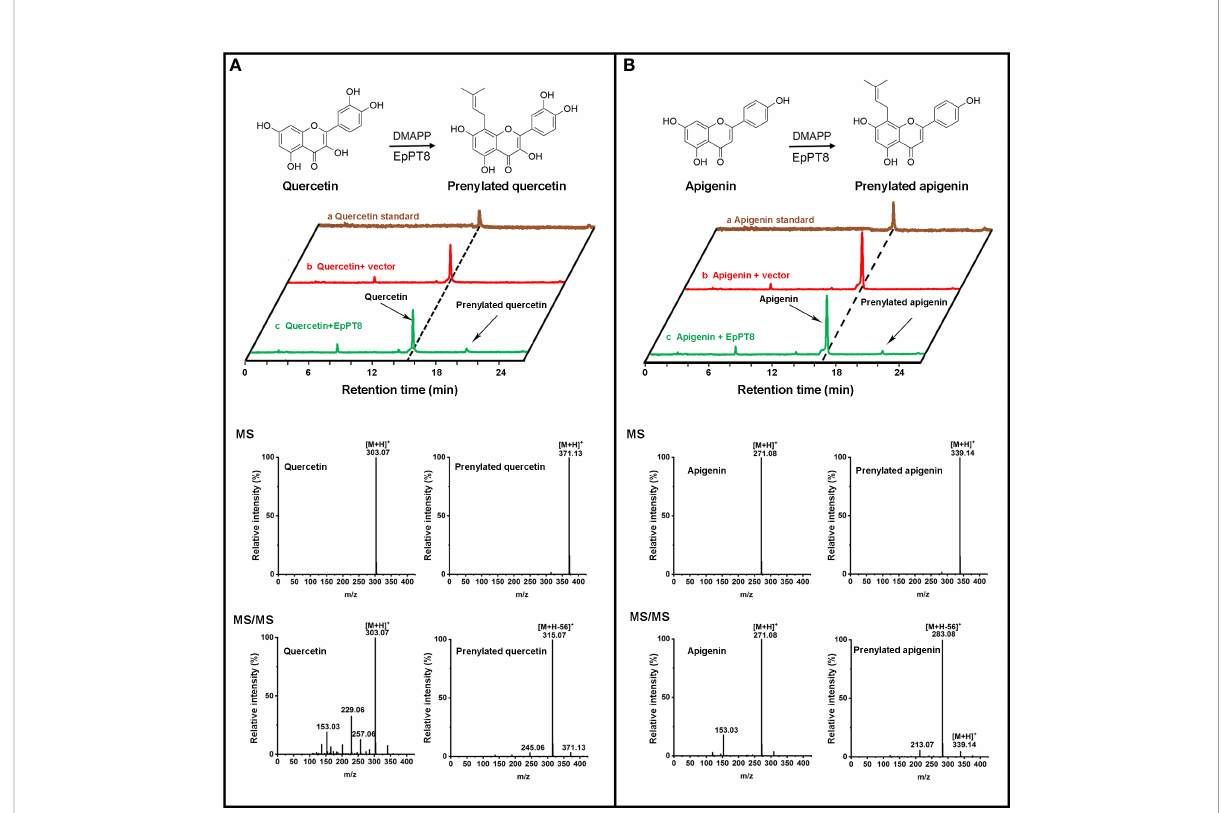
FIGURE 5 Determination of the enzymatic products of the recombinant EpPT8 protein with quercetin and apigenin as substrates. (A) The reaction with quercetin catalyzed by the recombinant EpPT8 protein. The HPLC chromatograph of reaction mix was shown in the upper panel; in the lower panel, MS (upper) and MS/MS (lower) chromatograms at 270 nm of quercetin and prenylated quercetin was on the left and right, respectively. (B) The reaction with apigenin catalyzed by the recombinant EpPT8 protein. The HPLC chromatograph of reaction mix was shown in the upper panel; in the lower panel, MS (upper) and MS/MS (lower) chromatograms of apigenin and prenylated apigenin were on the left and right,